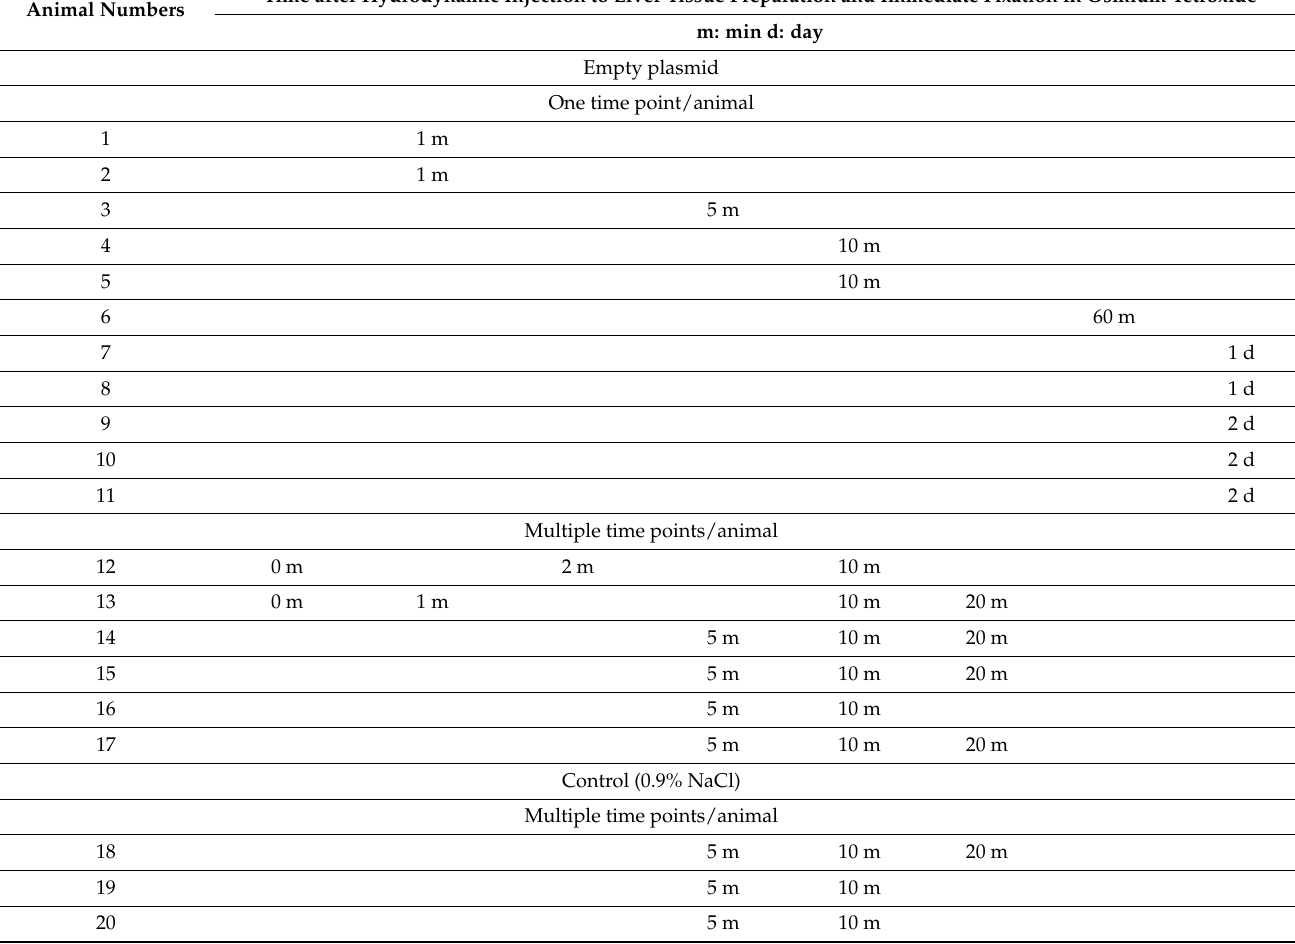
Table 1. Hydrodynamic injection and liver tissue preparation time